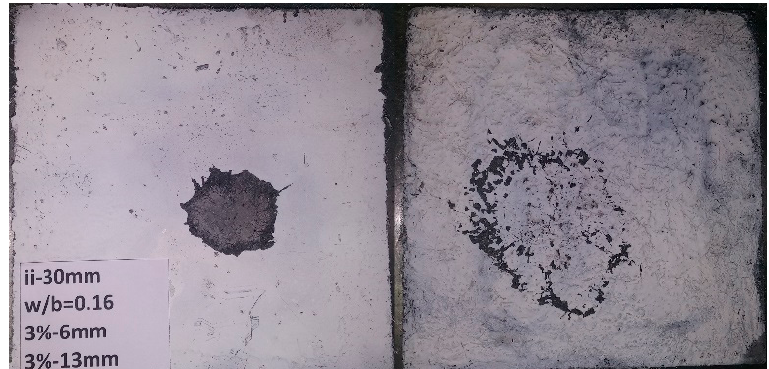
Figure 6. Failure type IIa (front face at the left and rear face at the right ).